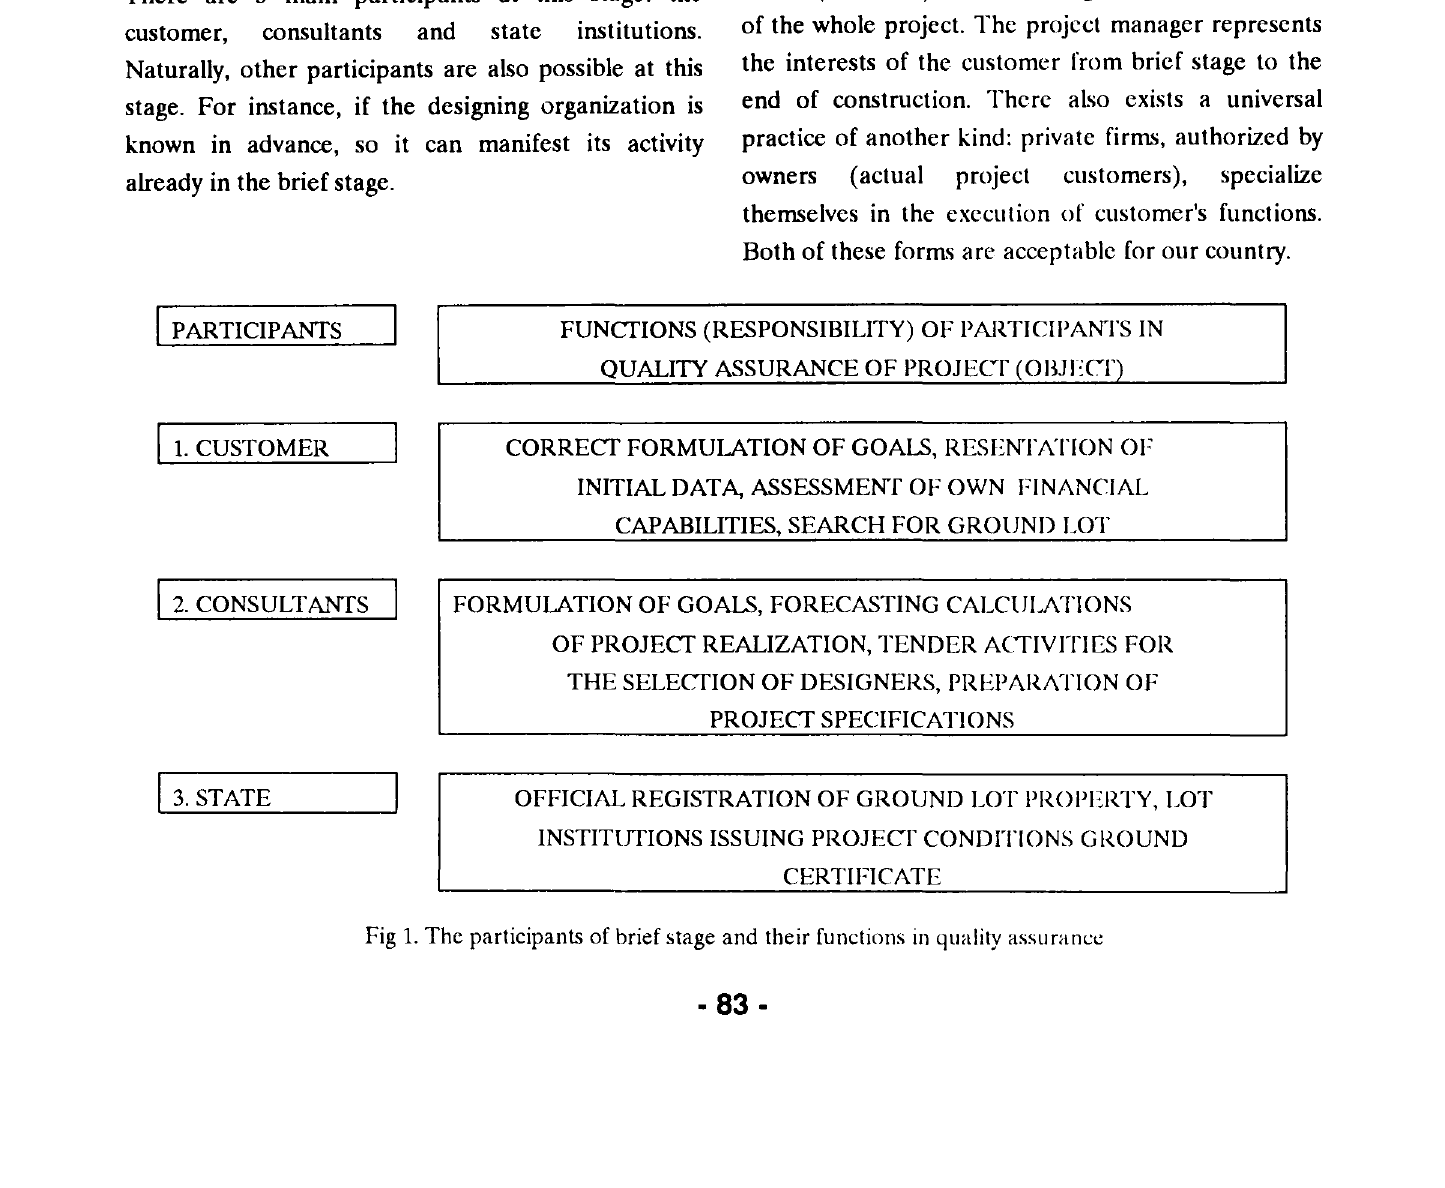
Fig 1. The participants of brief stage and their functions in quality assurance .